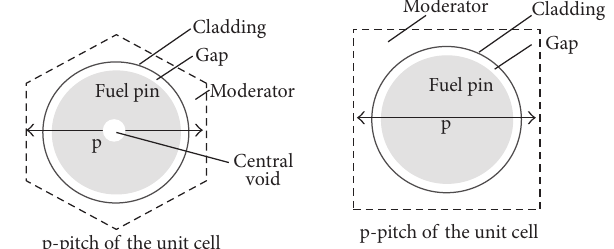
Figure 1: Types of geometries for the fuel pin-cell test cases within Exercise